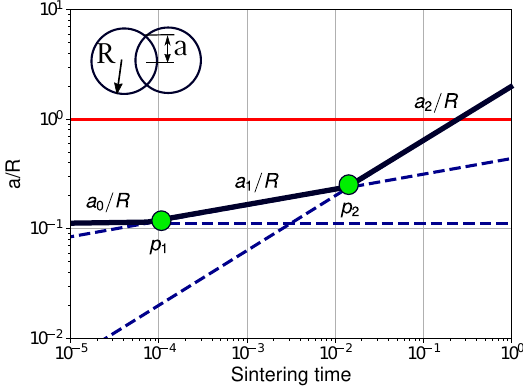
Figure 1. Visco-elasto-plastic contact Law. If δ 0 > δ max overlap enters to the "complete melting" of the particles.